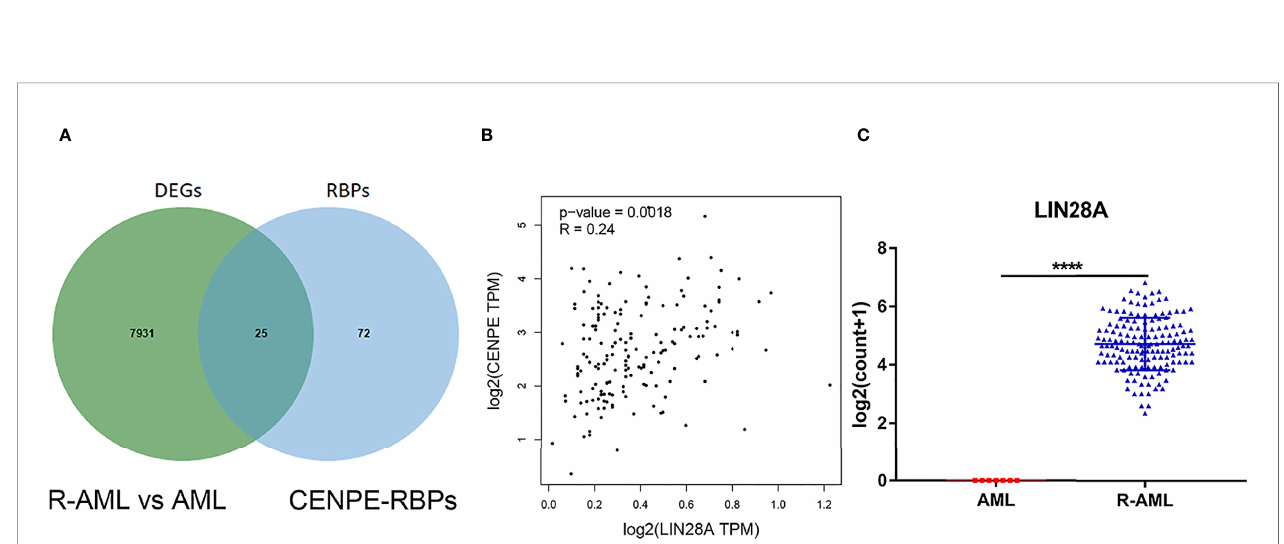
FIGURE 4 | CENPE interference effected Ara-C resistance in K562 and THP-1 cells. (A, B) K562 and THP-1 cells were treated with ascending concentrations of Ara-C (0.125 µM, 0.25 µM, 0.5 µM, 1 µM, 2 µM, 4 µM, and 8 µM). After 48 h, IC50 values were measured and analyzed by the CCK-8 method. The experiment was independently repeated three times and statistical differences between the si-NC and si-CENPE groups were analyzed. ** p < 0.01.